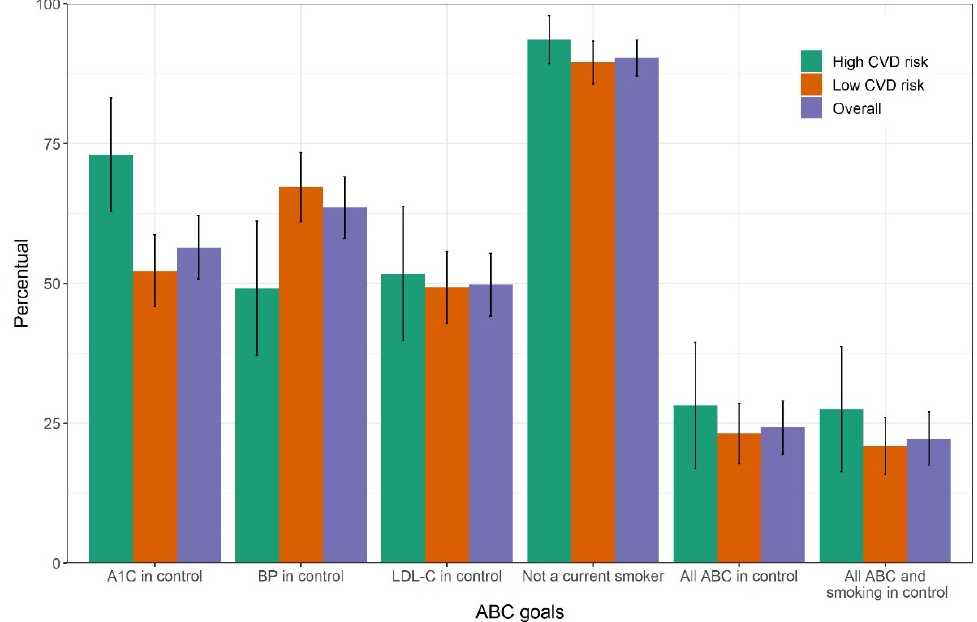
Figure 4. Sensitivity analysis. Percent attainment with 95% confidence interval for each of the three ABC goals, for the non-smoking goal and for combinations of goals among individuals with self-reported diabetes in the laboratory subsample of the Brazilian National Health Survey, 2014–2015. Goals here were relaxed for those aged 60 or over. ABC, A1C (A), blood pressure (B) and cholesterol (C). CVD, cardiovascular disease.